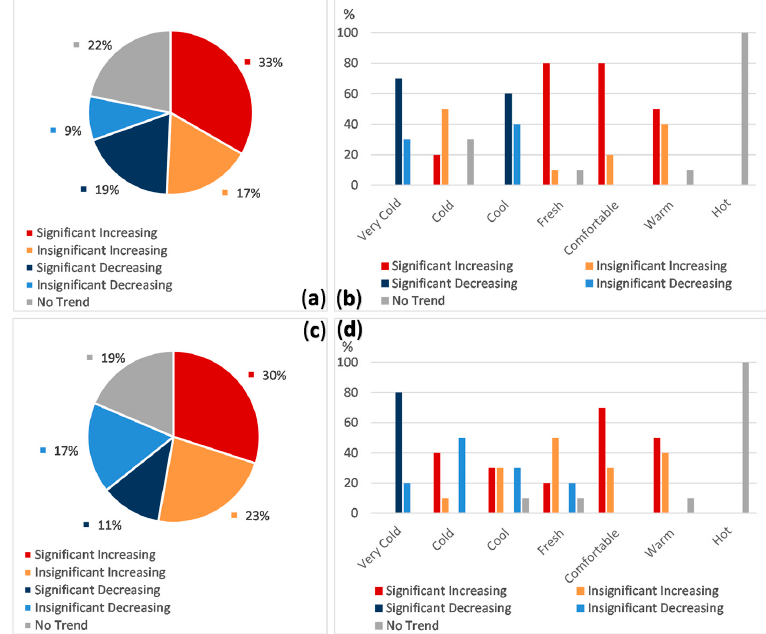
Figure 6. Trend types for TE index: ( a ) for all data sets of FO; ( b ) by thermal sensations classes of FO; ( c ) for all data sets of DOP; ( d ) by thermal sensations classes of DOP.